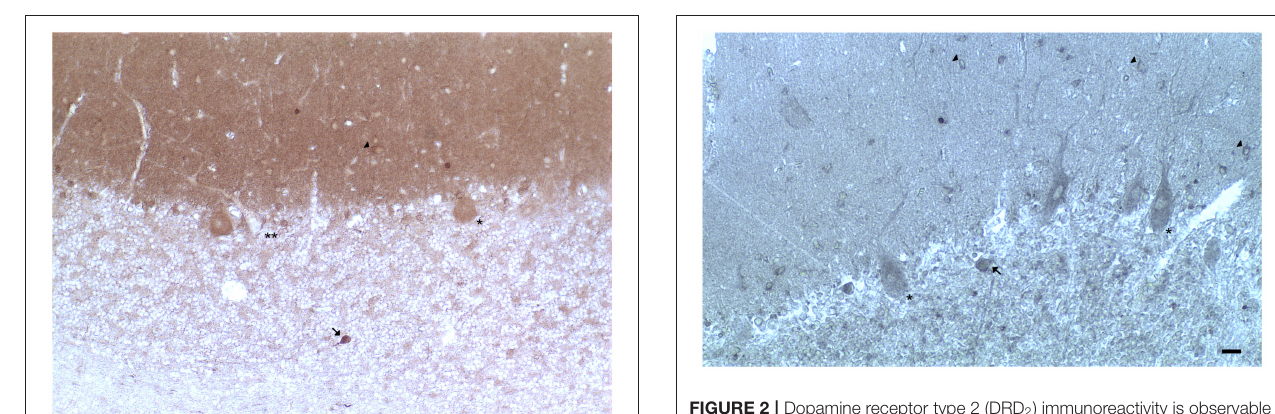
FIGURE 2 | Dopamine receptor type 2 (DRD 2 ) immunoreactivity is observable in neuronal bodies and processes in the layers of the cerebellar cortex. In the ML:DRD 2 immunoreactive basket and stellate neuron cell bodies (arrows), DRD 2 immunoreactive primary, secondary, and apical dendrites of Purkinje neurons, DRD 2 immunoreactive Purkinje neuron cell bodies ( single asterisk ). In the granular layer, DRD 2 immunoreactivity in space of Held; DRD 2 immunoreactive Golgi neuron cell body (arrow) (Scale bar: 20 µ m).